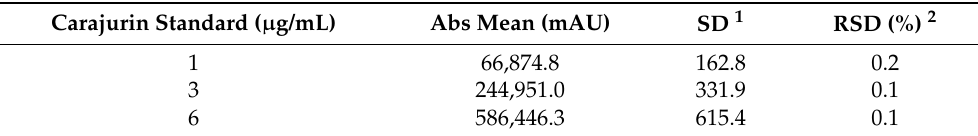
Table 3. Results of intra-day precision analyses of the new analytical method for quantification of carajurin.